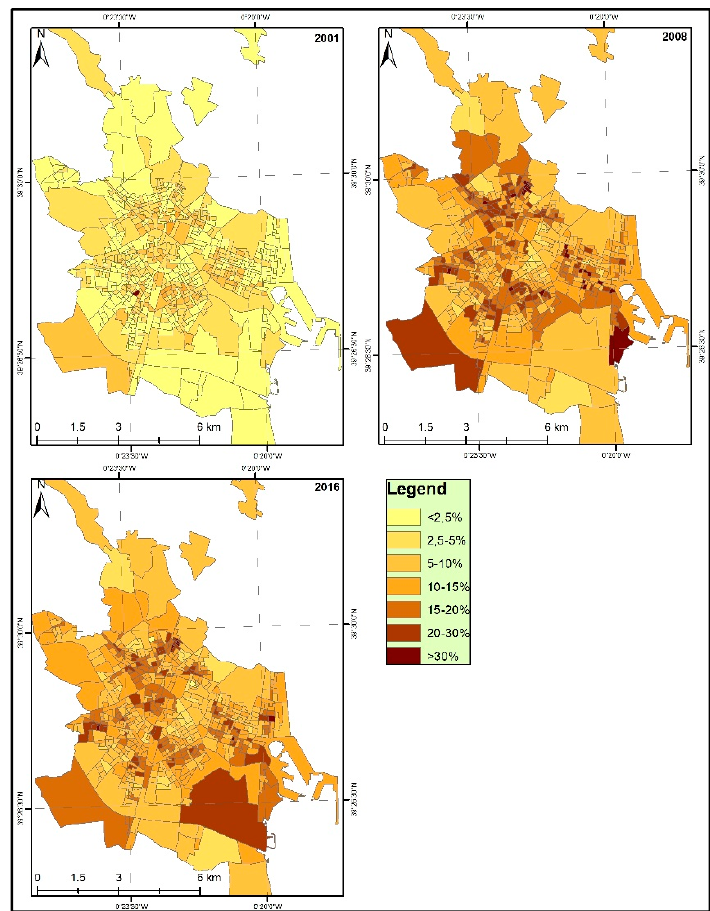
Figure 2. Immigrants’ percentage in Valencia City, at census section level, 2001–2016.